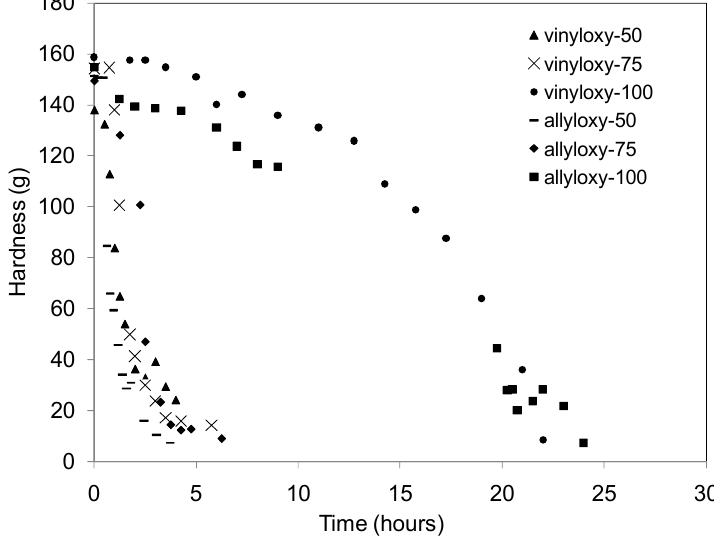
Figure 5. Change in 0.1 mm thick film hardness with time when placed in a 50% relative humidity (RH)